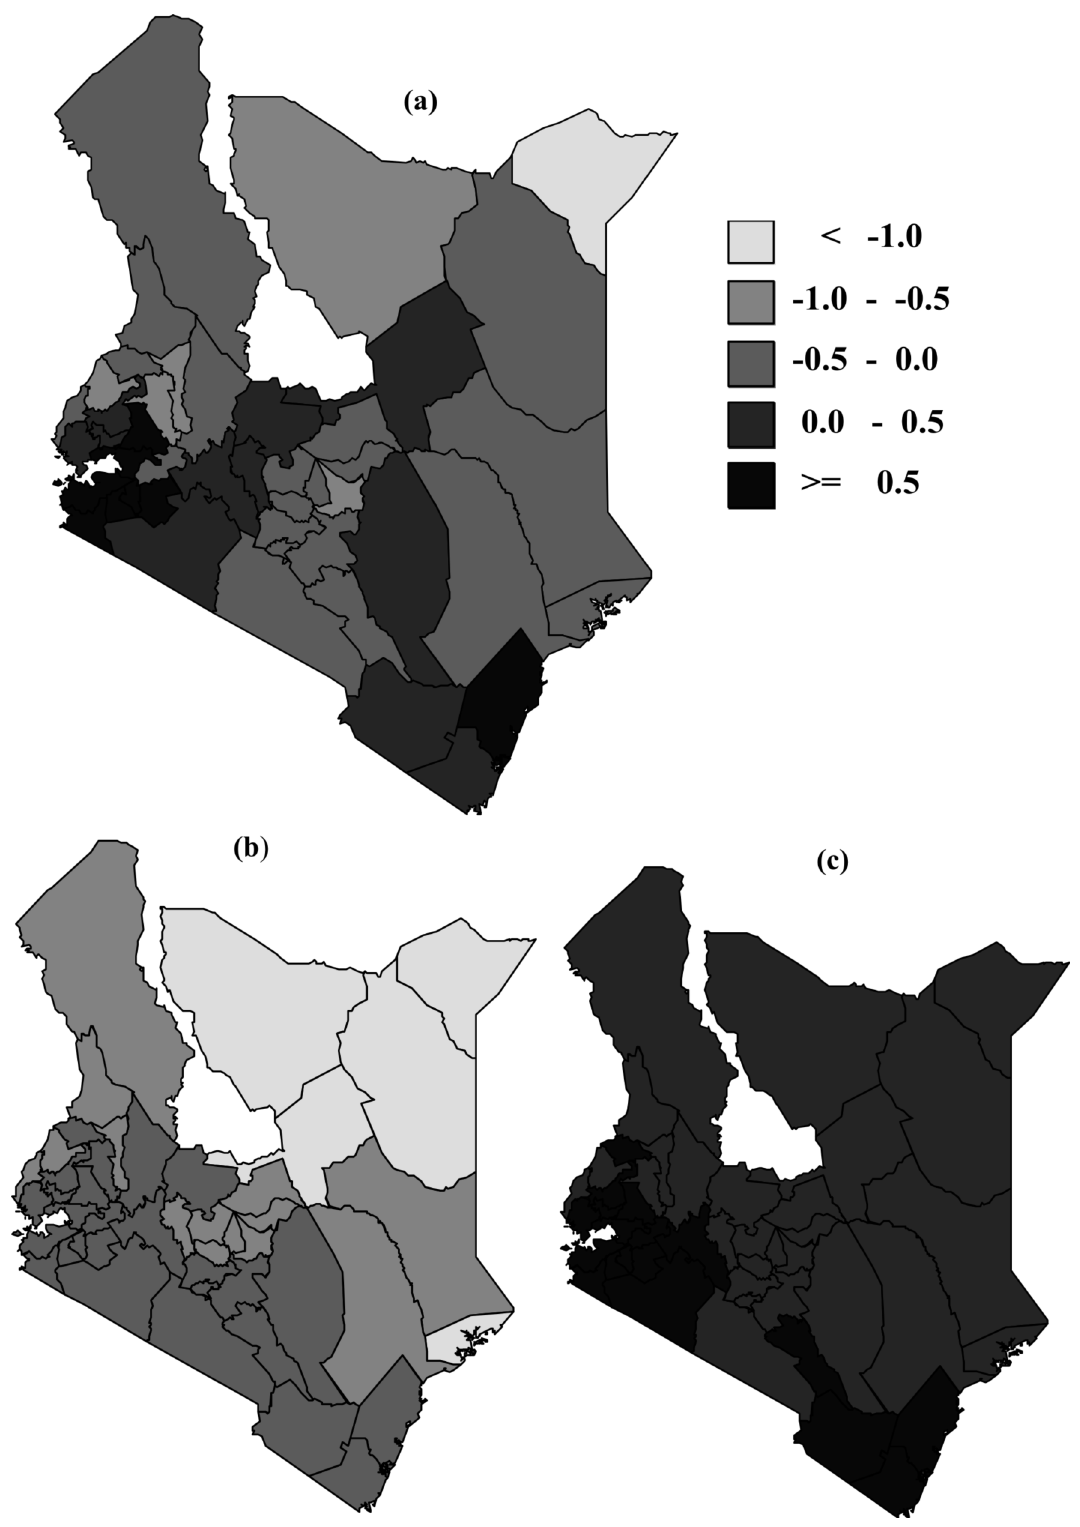
Figure 2. Residual spatial effect of county. Shown are the posterior means (a) and the corresponding lower (b) and upper (c) 95% credible limits.